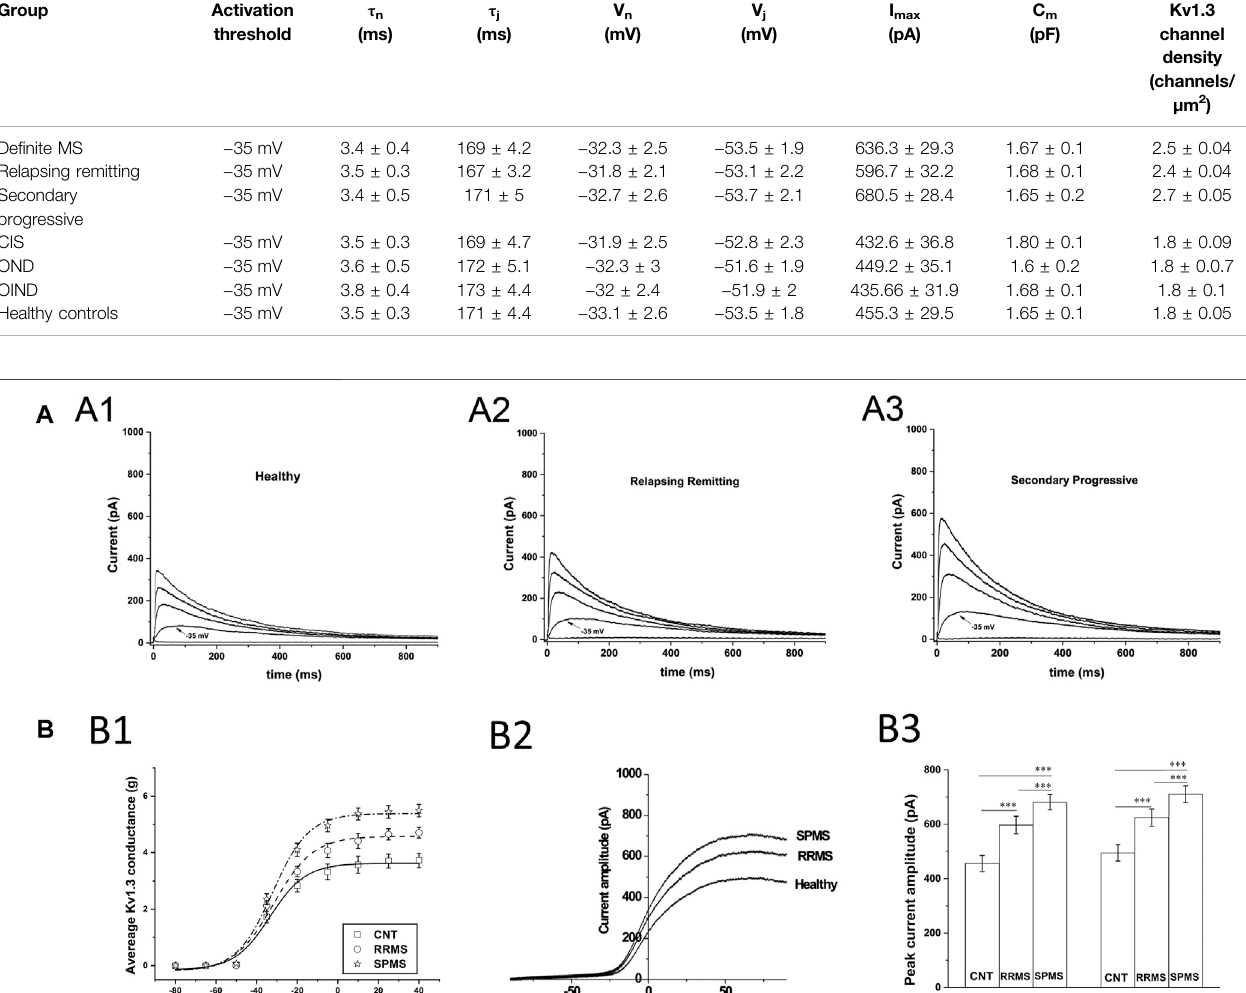
TABLE 3 | Electrophysiological properties of Kv1.3 channels, in patients with multiple sclerosis (MS) ( n (cid:1) 38) and control groups ( n (cid:1) 52). Data are presented as means ± SEM. (t